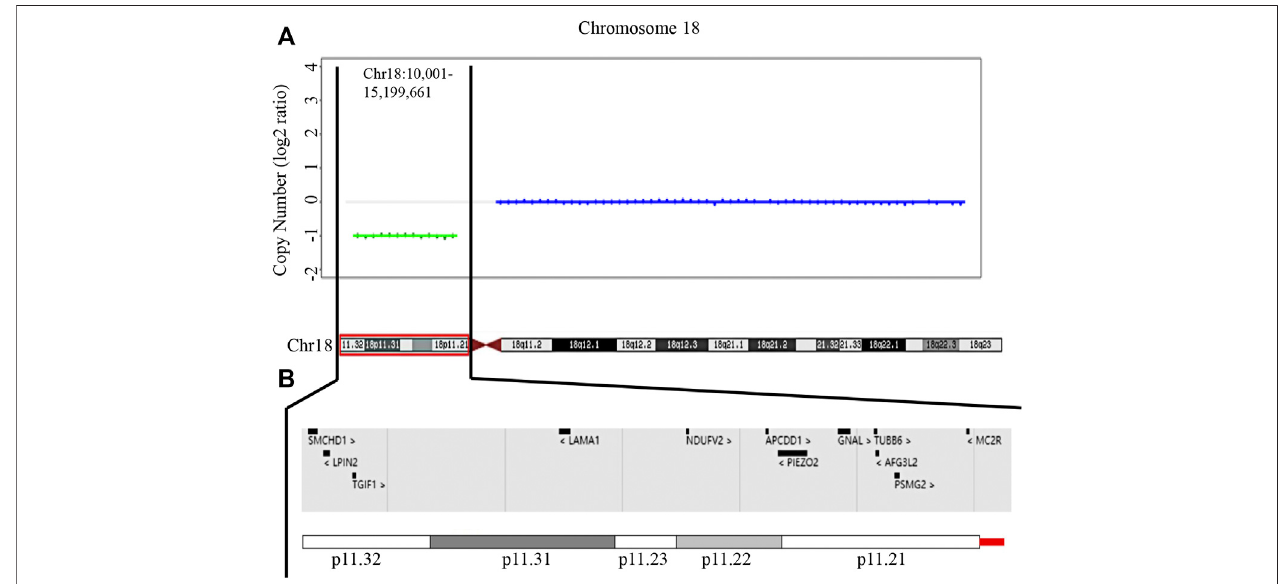
FIGURE 3 | Characterization ofthe identi fi ed 18p deletion analyzed by WGS. (A) WGS data showing the proband carries aheterozygous deletion at chromosome 18p11.32-11.21 (chr18:10,001-15,199,661) x1 (h19). (B) A view of deleted disease-associated genes in the patient in the DECIPHER